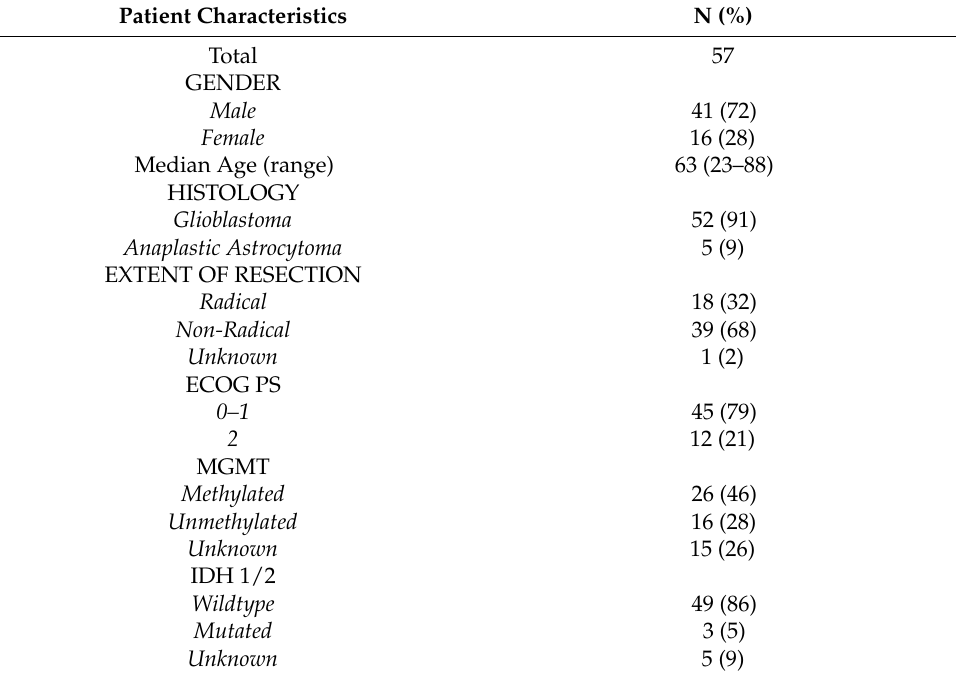
Table 1. Patient